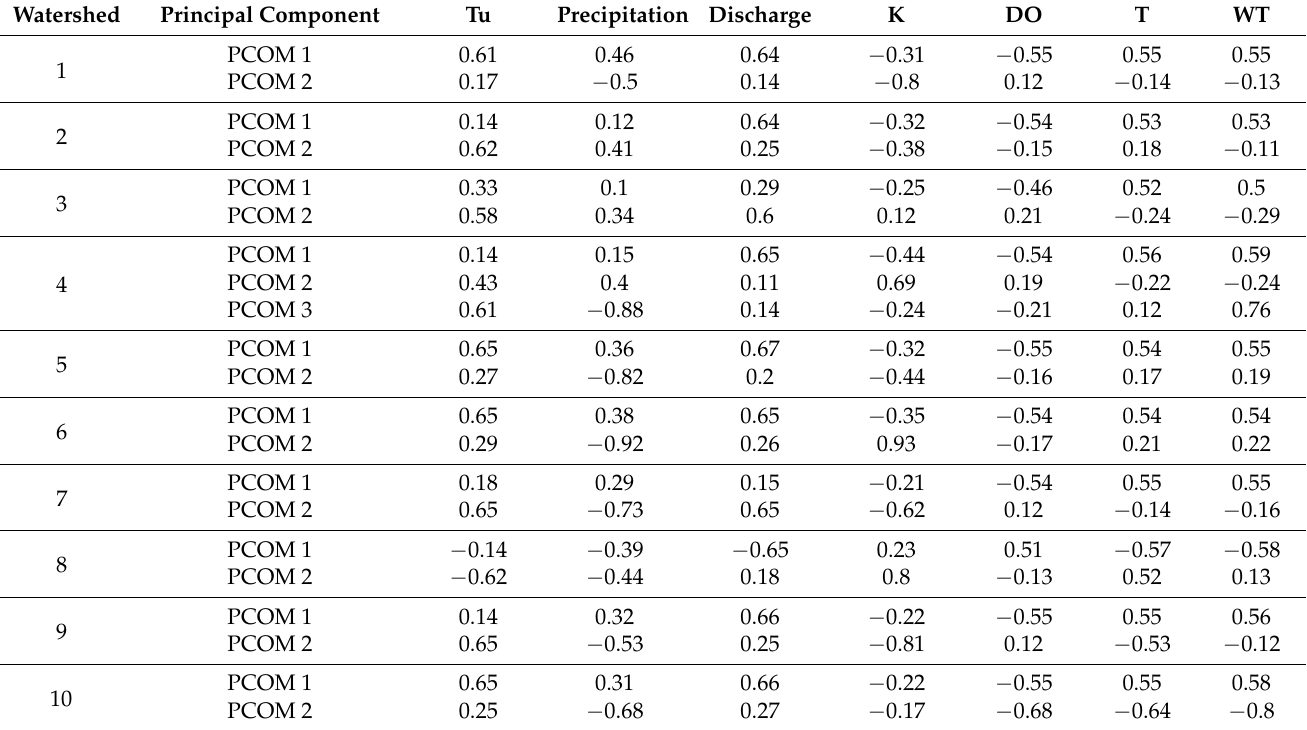
Table 3. Principal component